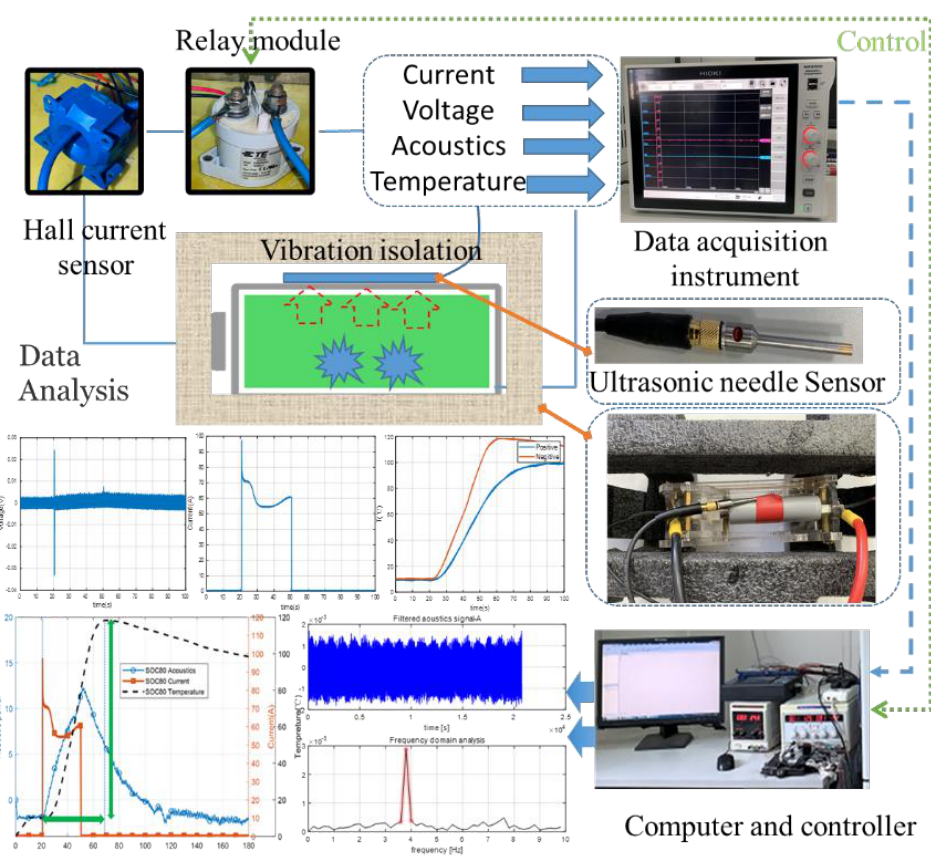
Figure 1. Schematic diagram of the ESC experimental setup based on AE.